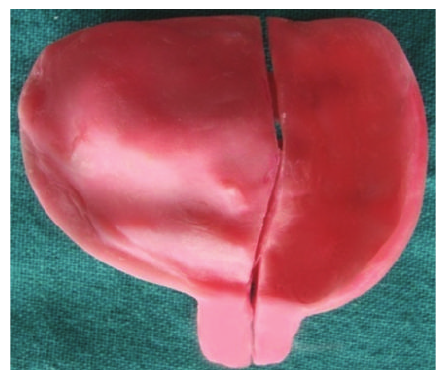
Figure 11: Assembled sectional tray.